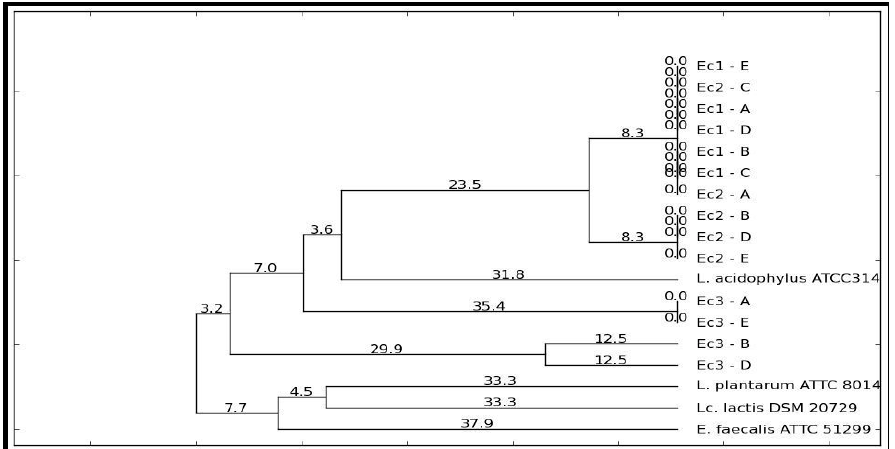
Figure 6. Dendrogram of LAB strains using WPGMA clustering method obtained after in vitro tests through GIS1 system as a measure of the impact of curcuma extracts. EC1 = ethanol/water extract; Ec2 = ethanol/water/acetic acid extract; Ec3 = ethanol/acetic acid extract.